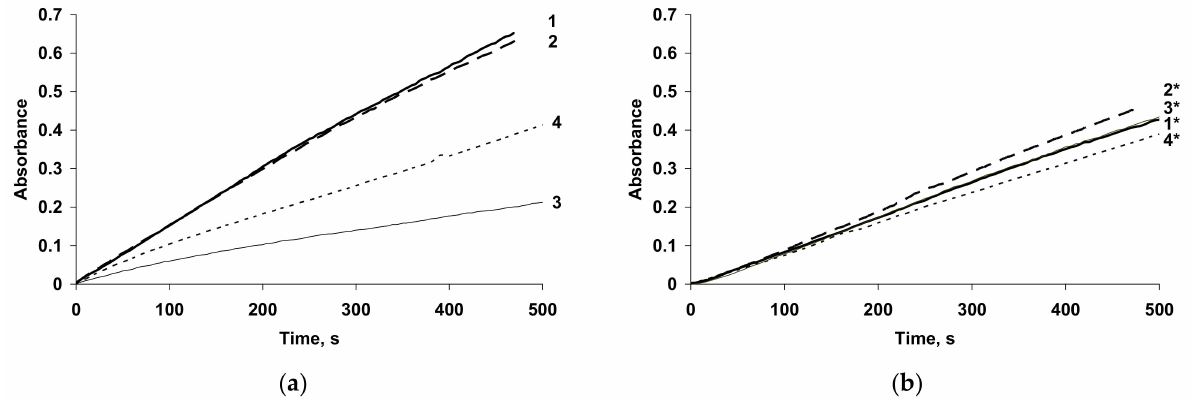
Figure 9. Time dependences of absorbance at 900 nm during GS synthesis of PPy in PSSA (1), PSSNa (1*), PAMPSA (2), PAMPSNa (2*), i-PASA (3), i-PASNa (3*), t-PASA (4) and t-PASNa (4*). Reprinted